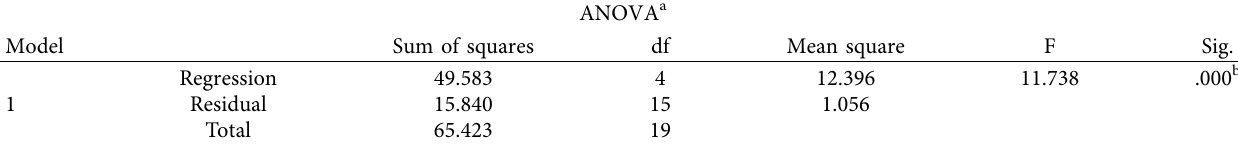
Table 5: ANOVA regression output.